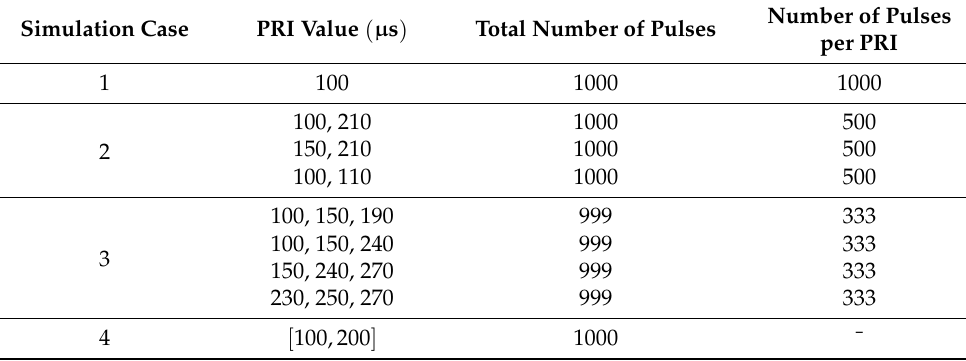
Table 2. Summary of the simulation case.